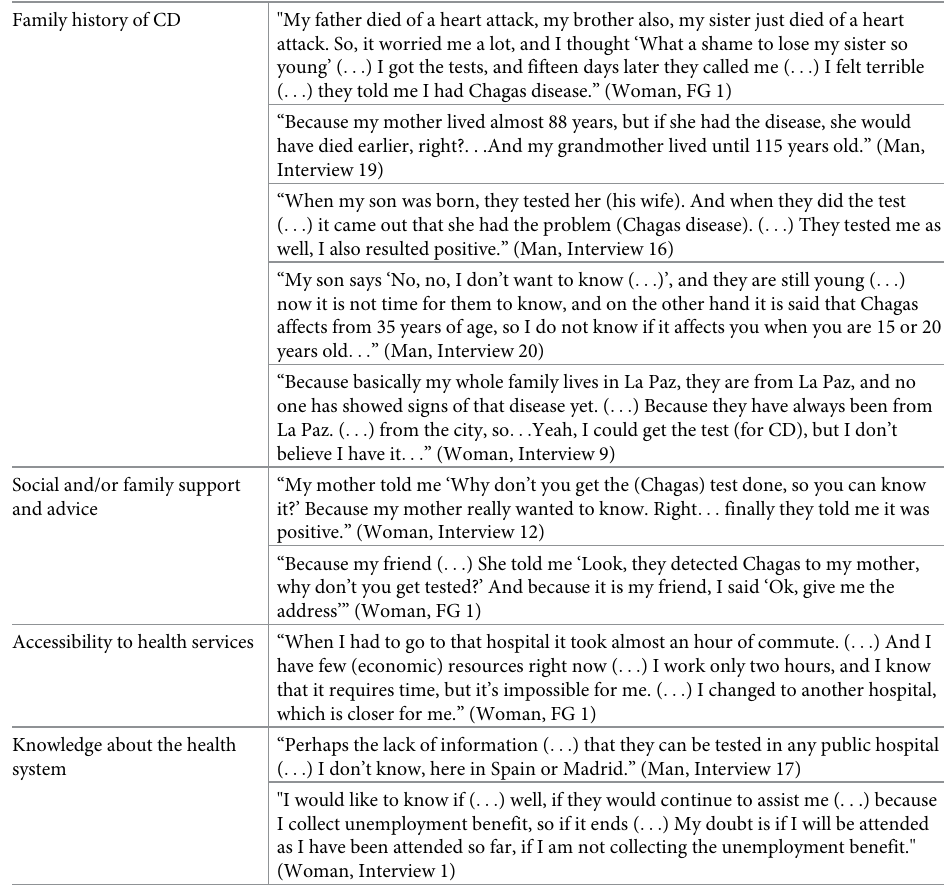
Table 6. Quotes related to enabling